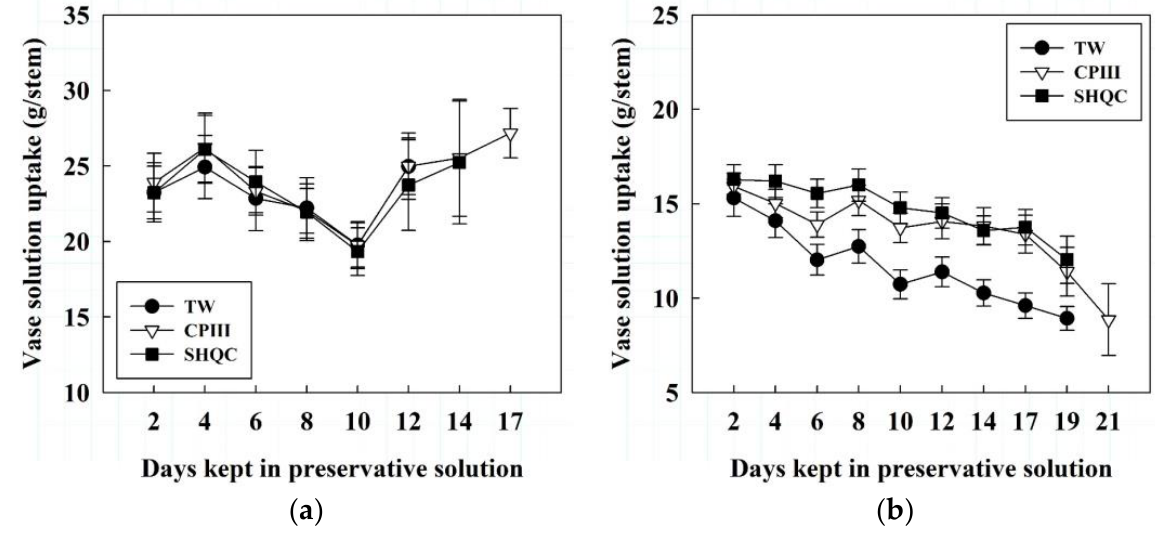
Figure 3. Changes in the vase solution uptake of cut hydrangea flowers ‘Verena’ kept in each preservative solution treatment in ( a ) 2019 and ( b ) 2020. Vertical bars indicate standard deviation of means ( n = 9). TW, tap water; CPIII, 1% Chrysal Professional III; and SHQC, 2% sucrose + 250 mg/L 8-hydroxquinoline + 100 mg/L citric acid. Table 1. Total solution uptake of cut hydrangea flowers ‘Verena’ kept in each preservative solution treatment in 2019 and 2020.